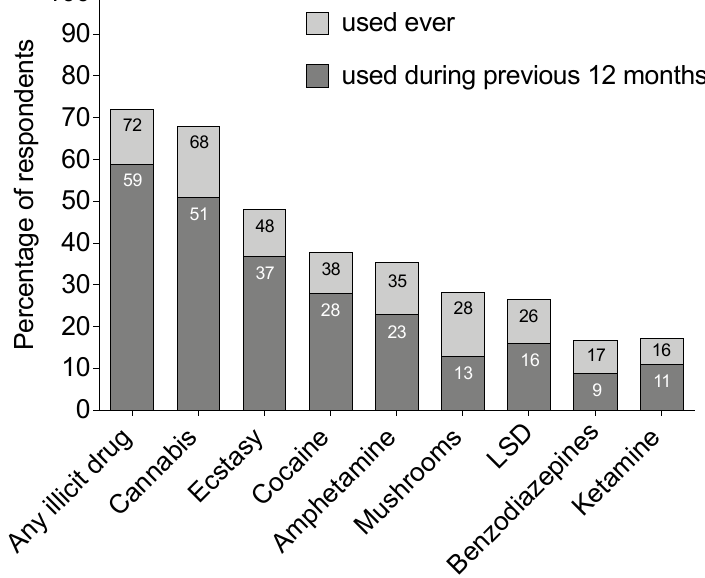
Figure 1. Drug use prevalence: lifetime and use during the past 12 months. Participants stated for each drug if they had used the drug during their lifetime (light grey) or during the last 12 months (dark grey). Within each bar, the percentage of people having used the drug is given. There are no missing data. However, participants stating no lifetime use for a certain drug were not shown the question on use of this drug during the last 12 months. Data are presented as percentage of the whole sample ( n = 1371). Illicit drugs are defined as substances classed as narcotics in Sweden, which are psychoactive compounds with abuse potential, including both recreational and prescription drugs. Excluded from this category were alcohol and tobacco and nitrous oxide or amyl/alkyl nitrates (poppers) since they are not classed as narcotics in Sweden. LSD, lysergic acid diethylamide.